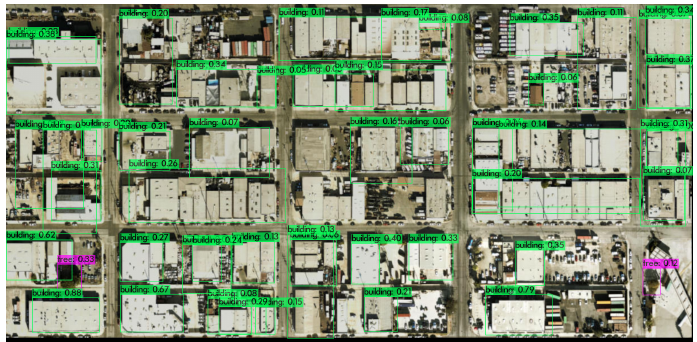
Figure 3. Sample YOLO v4 detection in location provided by China Center for Resources Satellite Data and Application (CRESDA). Showcases ability to segment buildings in a monochromatic